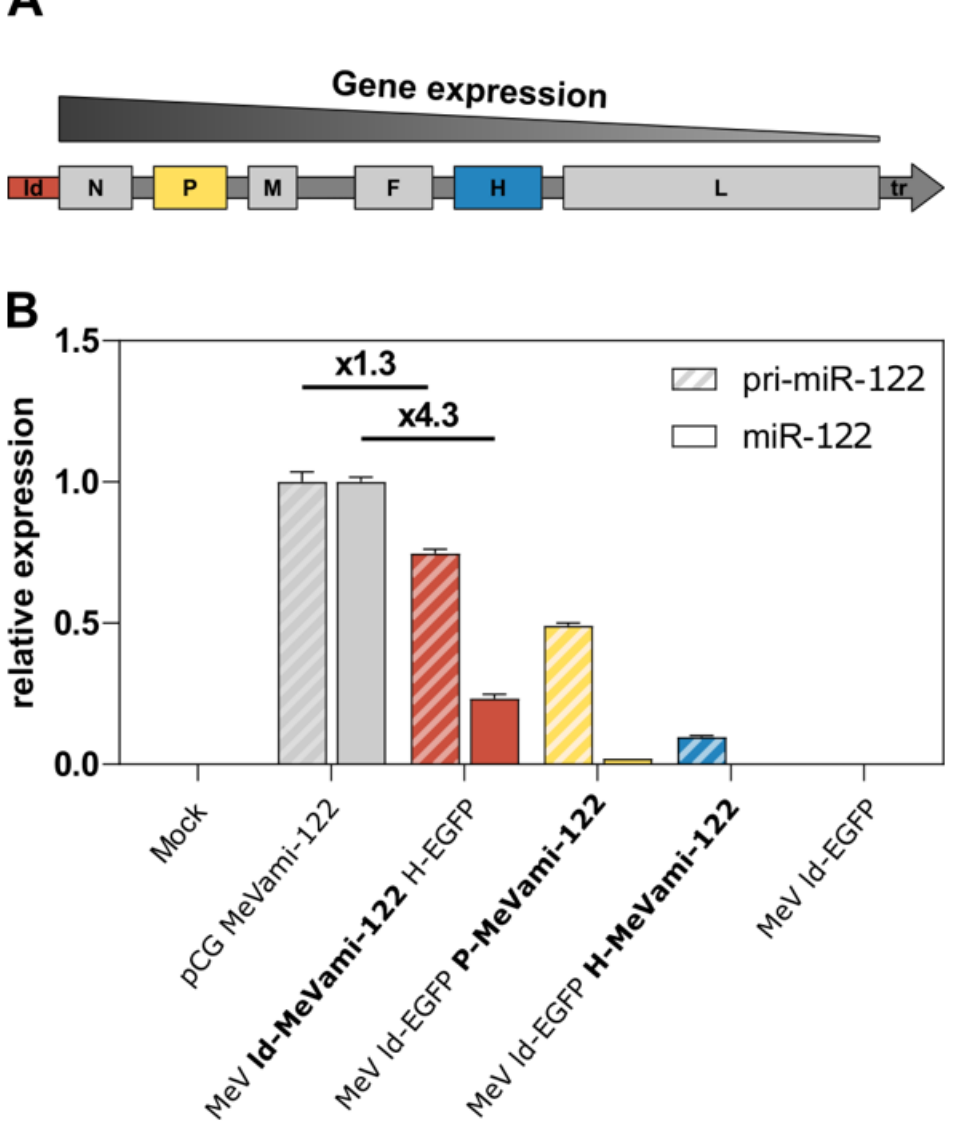
Figure 3. Transcriptional gradient and differential expression of (pri-)miR-122. ( A ) Schematic depiction of MeV genome with indicated gene expression gradient. Genes further upstream in the genome are transcribed more frequently. ( B ) Relative expression of pri-miR-122 and mature miR-122 in cells transfected or infected with MeVami-122-encoding vectors. Vero cells were ei- ther infected with recombinant, MeVami-122-encoding MeV at an MOI of 0.3 or transfected with 0.5 µ g/mL pCG MeVami-122 and harvested 30 h p.i./p.t. Results of qPCR analysis are depicted as viral pri-miR-122/mature miR-122 expression relative to pri-miR-122/mature miR-122 expression, respectively, in transfected cells (pCG